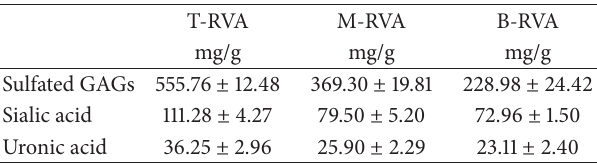
Table 1: Sulfated GAGs, sialic acid, and uronic acid contents of regrowth velvet antler extracts.